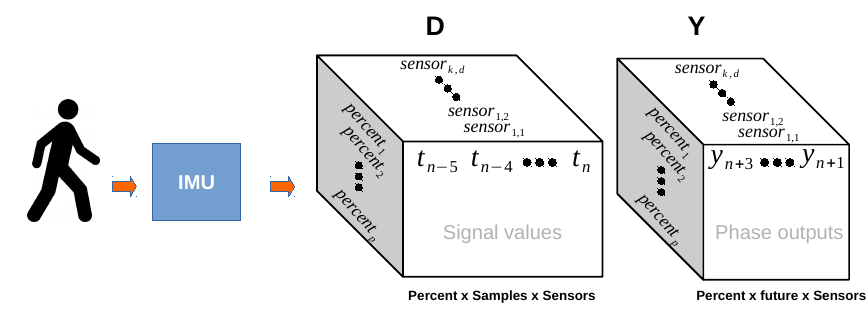
Figure 3. This figure illustrates how the matrix D was created. Every sample in the inertial measurement unit (IMU) is delayed by n times (in this case five times). The output matrix is shifted n times into the future (in this case three